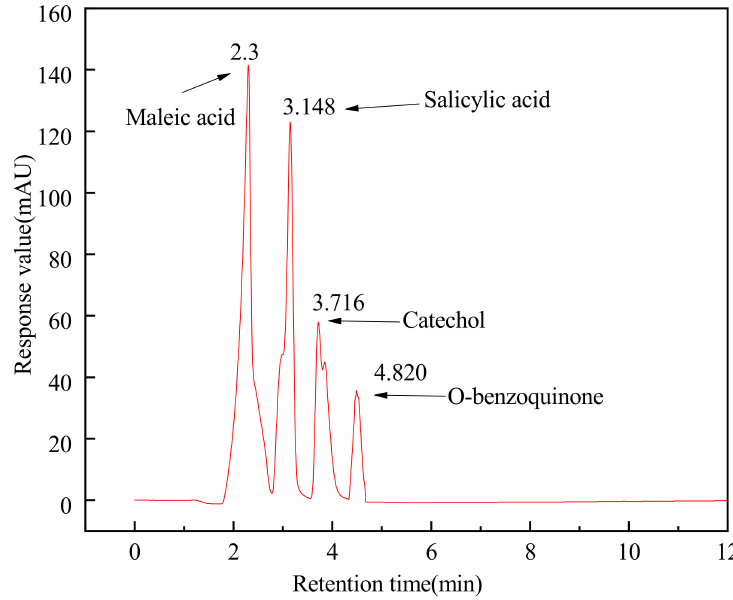
Figure 12. HPLC chromatogram of mixed standard